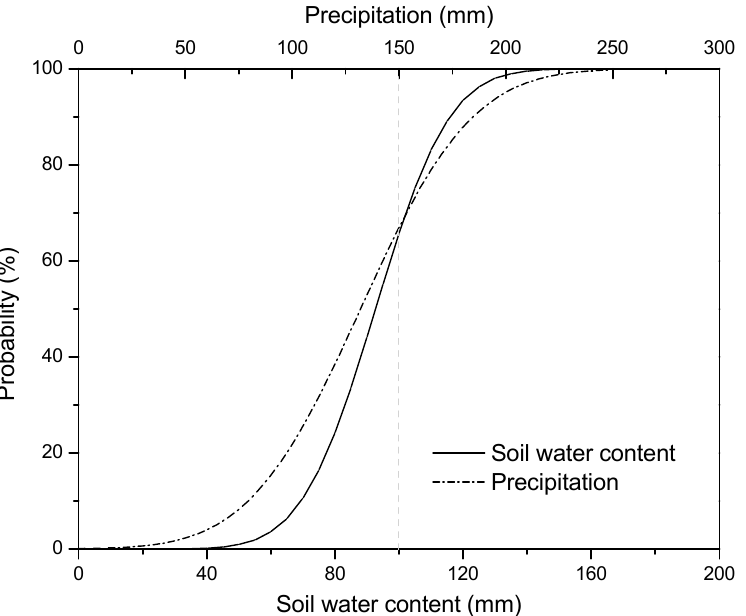
Figure 7. Probability of soil water content at planting and precipitation during spring wheat growing season at Dingxi, Gansu province, China.